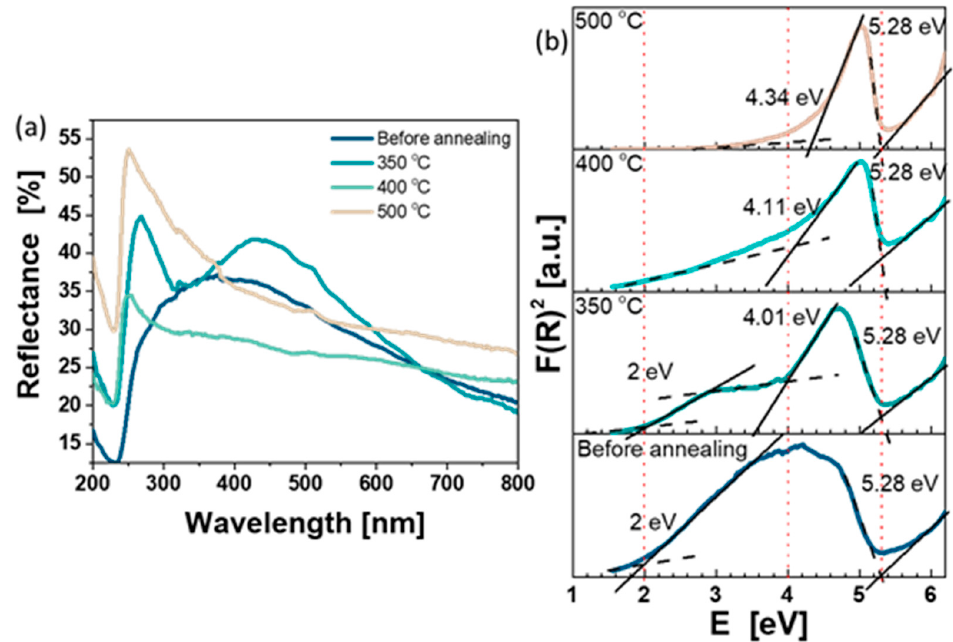
Figure 4. UV-Vis diffuse reflectance spectra of nanoporous zirconia arrays before and after annealing at different temperatures ( a ). Tauc plot of the Kubelka – Munk function for direct transitions ( b ).